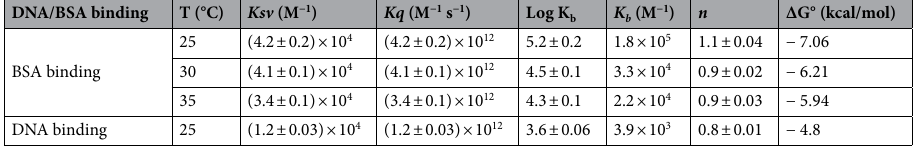
Table 6. Stern–Volmer constant ( Ksv ), Binding constant ( K b ), number of binding sites ( n ) and Quenching constant ( Kq ).